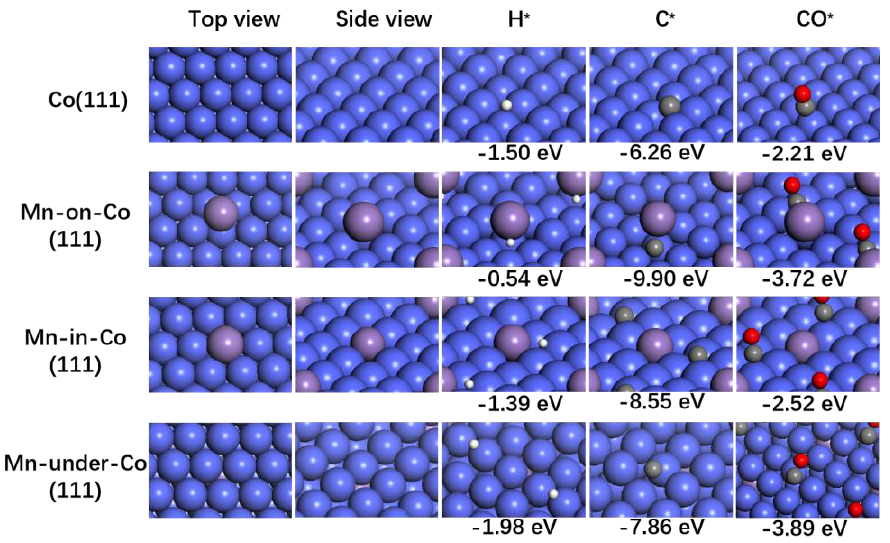
Figure 6. DFT-optimized configurations of H, C, and CO binding on Co(111), Mn-on-Co(111), Mn-in-Co(111), and Mn-under-Co(111) surfaces. Blue, purple, grey, red, and white spheres represent Co, Mn, C, O, and H atoms, respectively. “*” represents an adsorption state.